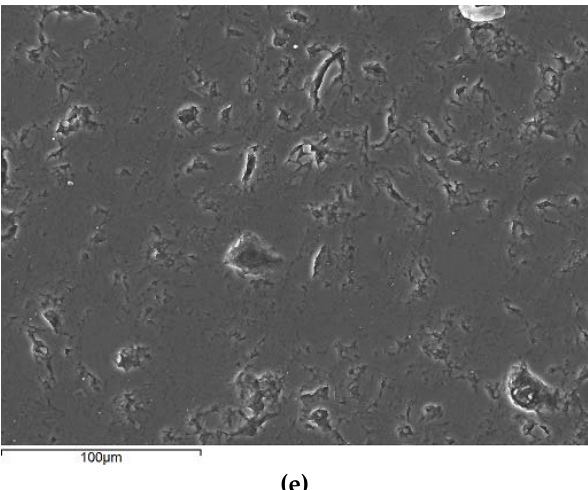
Figure 7. Secondary electrons’ images of polished surfaces of ( a ) the reference clay-body, ( b ) W20, ( c ) W50, ( d ) W80, and ( e ) CSM, fired at 1000 °C. Scale is 100 μ m. Magnification (×400).